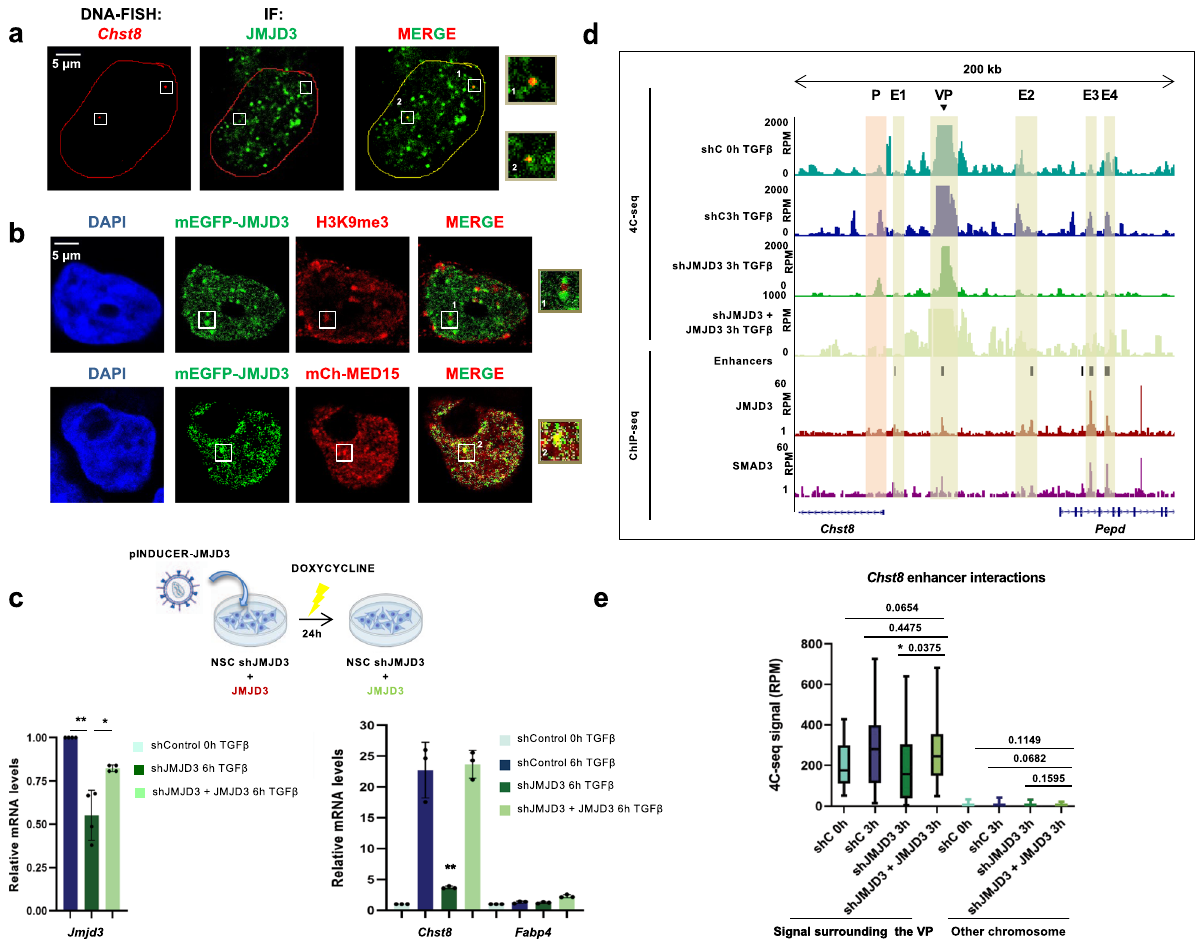
Fig. 7 JMJD3 promotes Chst8 gene transcription and enhancer-cluster assembly. a Immuno-FISH for JMJD3 protein (green) and Chst8 locus (red) on HEK293T cells. Chst8 FISH signal colocalizes with JMJD3 condensates (on the right). Results are representative of three independent experiments. b In HEK293T cells expressing mEGFP-JMJD3 (transfection of 0.05 ug, green) the localization of the H3K9me3 mark and MED15 was analyzed using immuno fl uorescence staining with an anti-H3K9me3 antibody (red). MED15 localization was analyzed following the red signal in cells co-expressing mEGFP-JMJD3 and mCherry-MED15. Nuclei were visualized with DAPI (blue). Colocalizations are shown in yellow. Scale bar, 5 μ m. The images are representative of three independent experiments with similar results . c JMJD3-depleted NSCs (shJMJD3) expressing JMJD3 (shJMJD3 + JMJD3) were treated with TGF β for 6 h. Total RNA was prepared and the mRNA expression levels of the Chst8 gene were determined by qPCR. mRNA levels of the Fapb4 gene were used as a negative control. Values were normalized to the Gapdh gene. Data are presented as mean values + / − SEM. * p < 0.05, ** p < 0.01 ( P values were calculated using two-tailed Student ’ s t test, p = 0.00850428 and p = 0.03608055 ( Jmjd3 ); p = 0.00971346 ( Chst8 )). Results are representative of four independent experiments. Source data are provided as a Source Data fi le. d UCSC Genome Browser captures show 4C-seq pro fi les spanning 200 kb around the VP Chst8 enhancer (black arrow) in control, shJMJD3 and shJMJD3 + JMJD3 NSCs treated with TGF β during 3 h. ChIP-seq signals of SMAD3 and JMJD3 upon TGF β stimulation are shown. The location of the members of the EC is also indicated with yellow boxes. e Boxplot displays the averaged values obtained from two biological independent replicates of RPM signals of the peaks located 500 kb around the VP enhancer - excluding the nearest ±20 kb - (mm10 chr7:33841896-35860773) in control, shJMJD3 and shJMJD3 + JMJD3 NSCs treated with TGF β during 3 h. An independent region located in another chromosome (mm10 chr4:33076383-35216108) was used as a negative control. Boxes comprise values from Q1 to Q3 of the dataset; line corresponds to median value; whiskers show the data range (from min. to max. values within dataset). p-values are the result of a Wilcoxon-Mann – Whitney